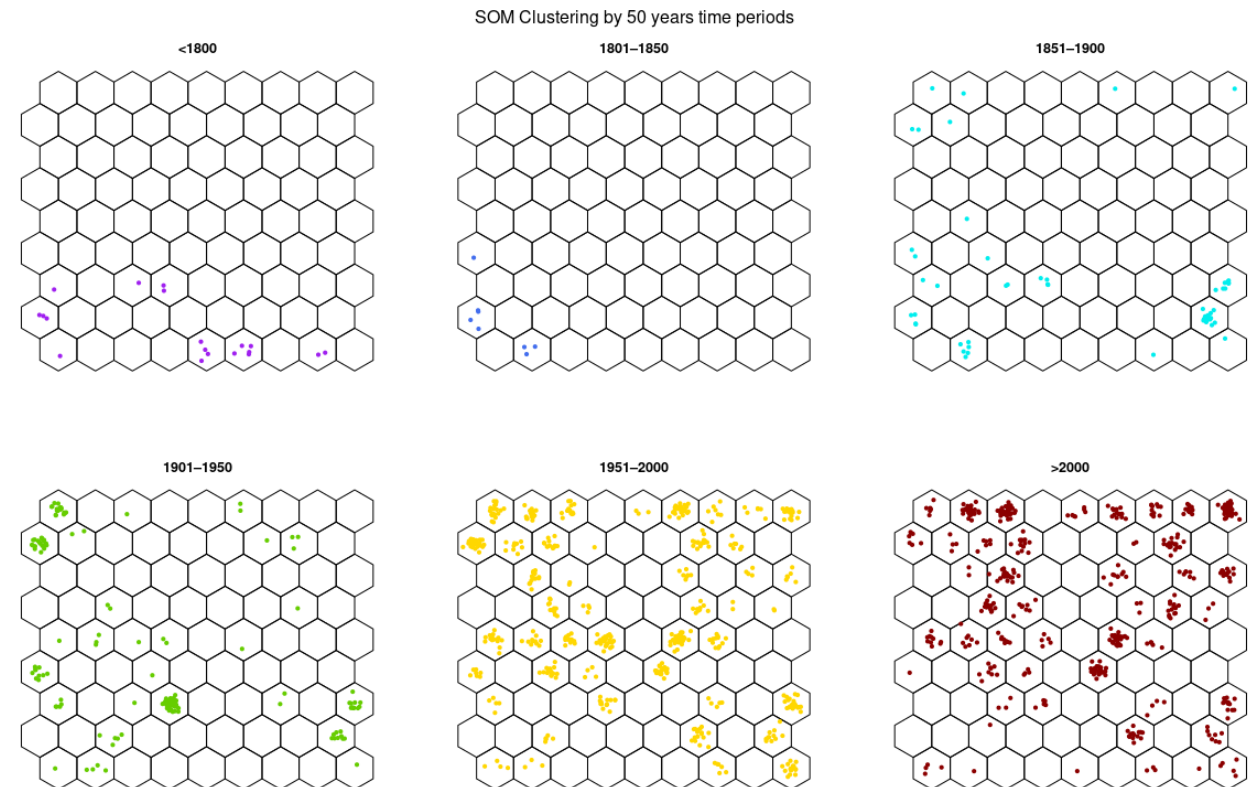
Figure 2. SOM clustering for the germplasm of 1219 potato accessions by 50-year breeding period ([<1800], [1801–1850], [1851–1900], [1901–1950], [1951–2000], [2000–2021]) .. Each dot represents